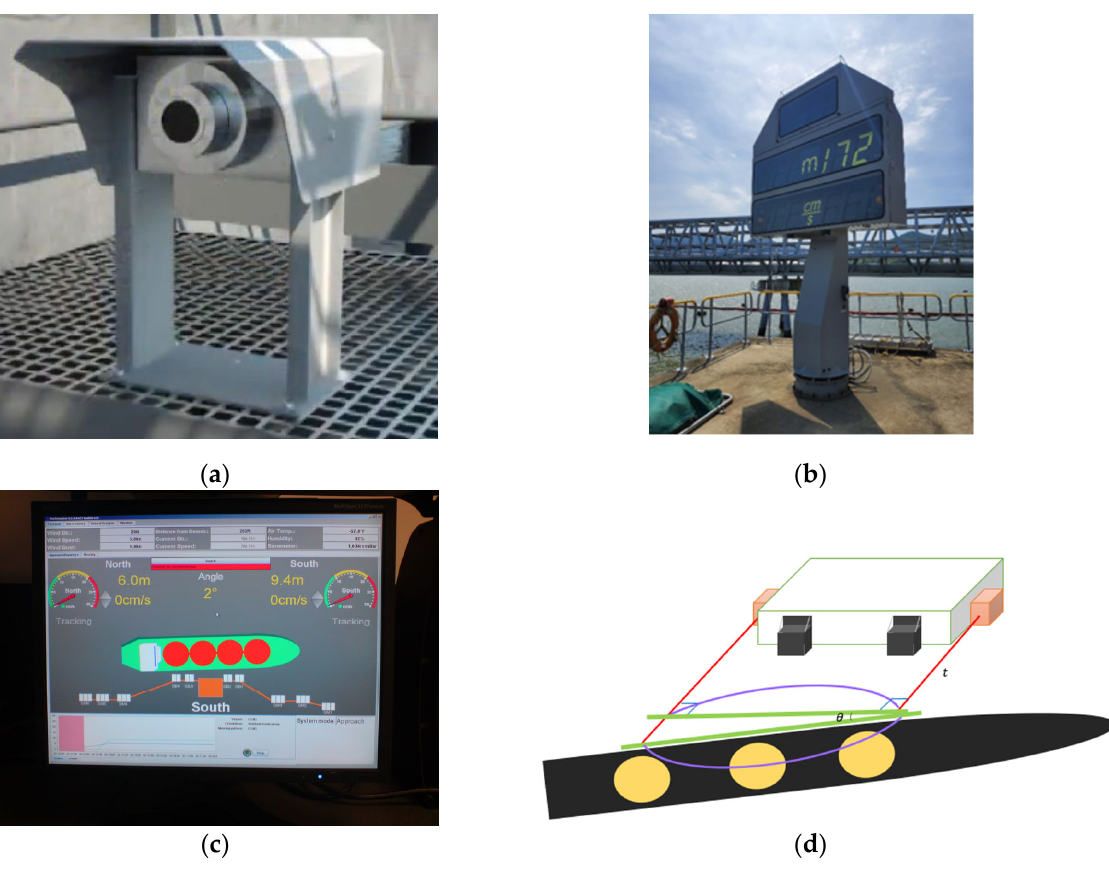
Figure 4. Docking aid system (DAS) measurement principle and constituent system: ( a ) laser LMU 500E, ( b ) digital large display, ( c ) live data, and ( d ) DAS conceptual diagram .